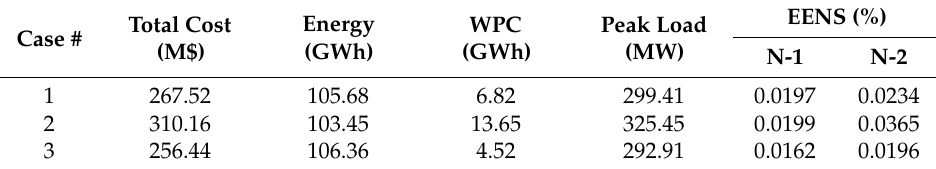
Table 2. Result comparison for cases 1–3 with 50 MW wind power.